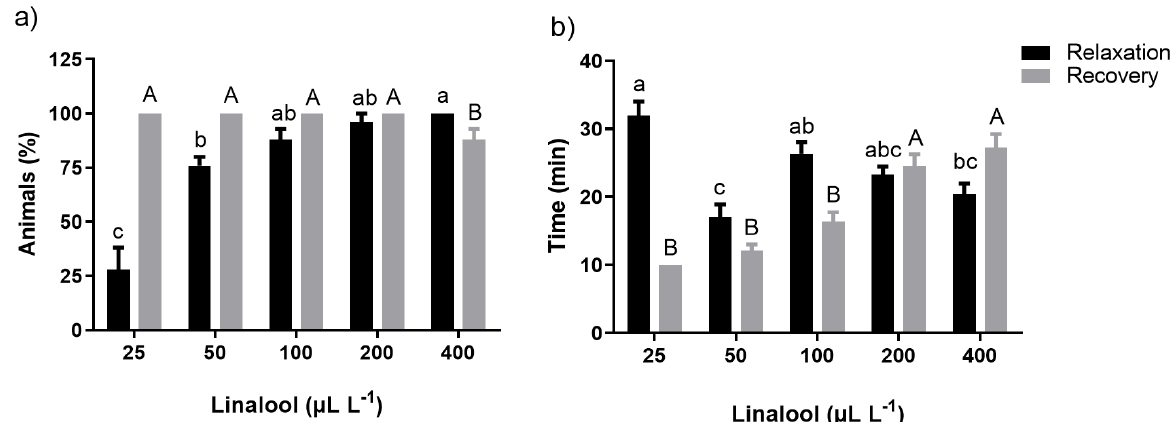
Figure 2. Percentage of relaxation (a) and recovery of Pomacea canaliculata exposed to linalool and their respective times (b). Lowercase letters indicate statistical difference between linalool concentrations in the relaxation stage, and uppercase letters indicate statistical difference between linalool concentrations in the recovery stage (Kruskal-Wallis test and Dunn post-hoc, p < 0.05, as mean ±